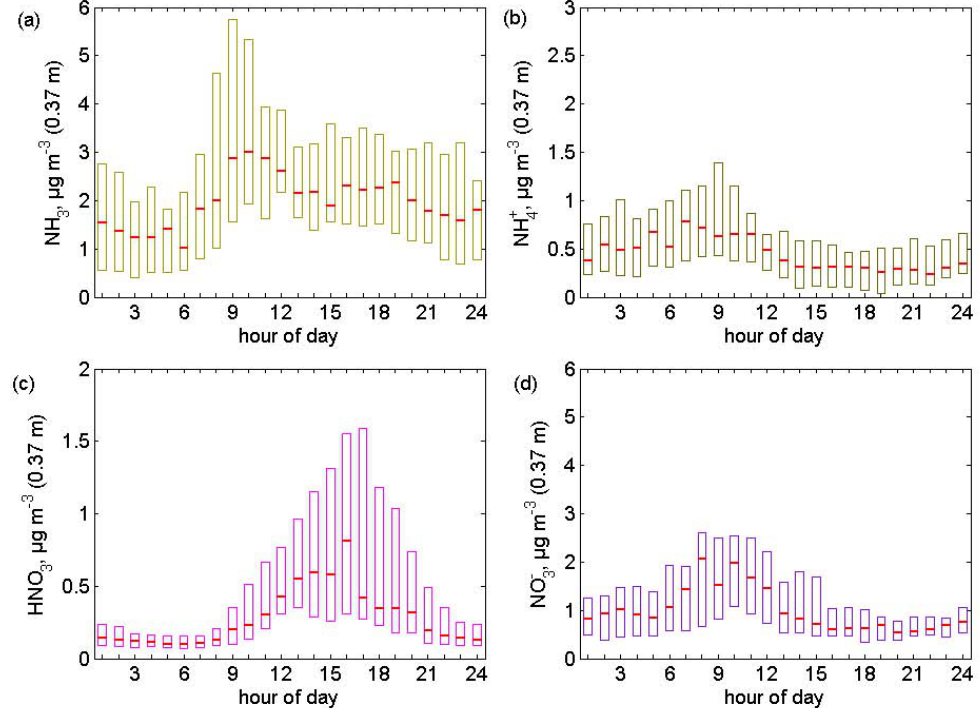
, (c) HNO 3 , and (d) particulate NO − measured at z =0.37m (above ground). Red 4 3